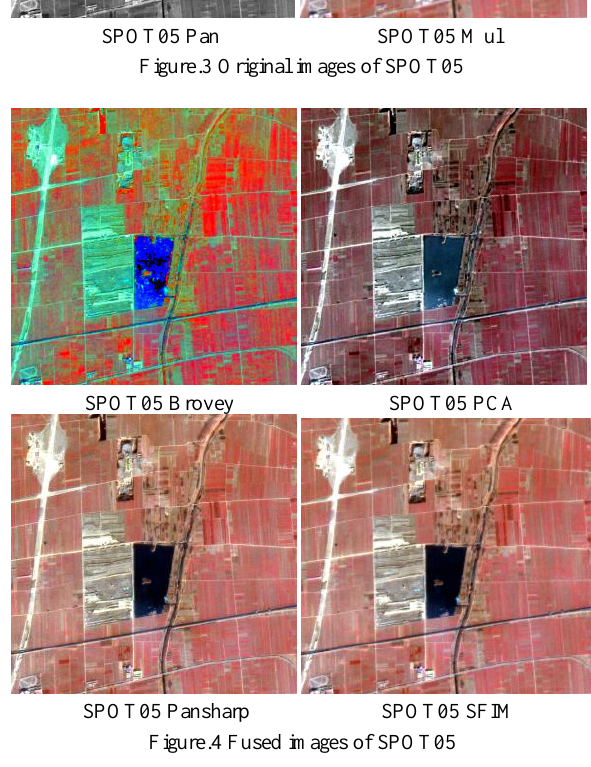
Figure.4 Fused images of SPOT05